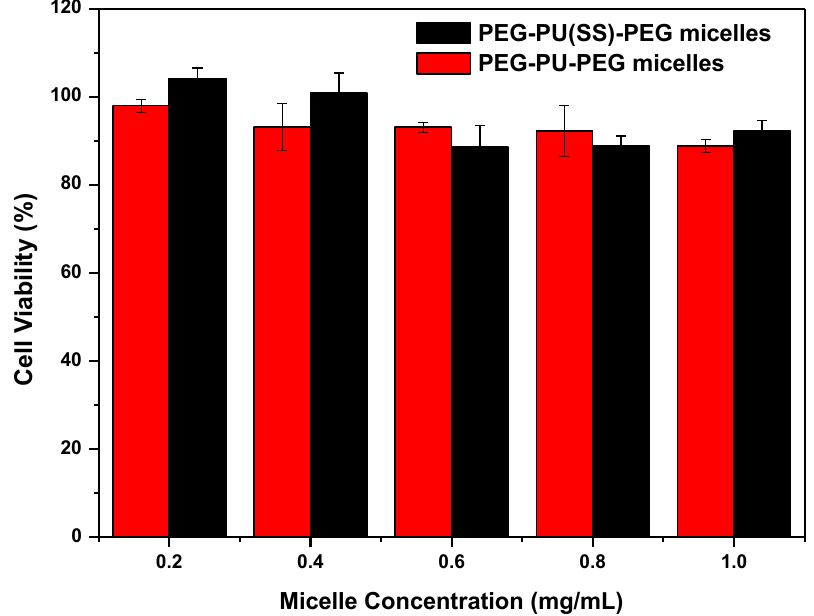
Figure 7. Cytotoxicity of PEG-PU(SS)-PEG and PEG-PU-PEG micelles. The cells (C6) were incubated with micelles for 24 h. Data are presented as the average ± standard deviation ( n = 6).